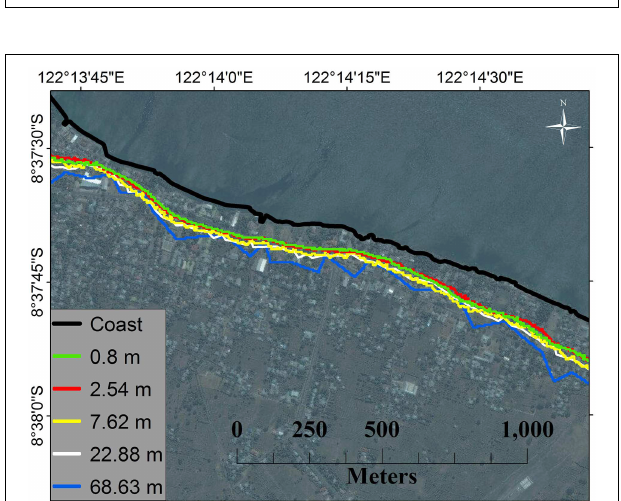
FIGURE 10 | Comparison of modeled tsunami inundation depth for ANUGA models using the IFSAR DTM for different mesh resolutions for part of Maumere. See Figure 5B for